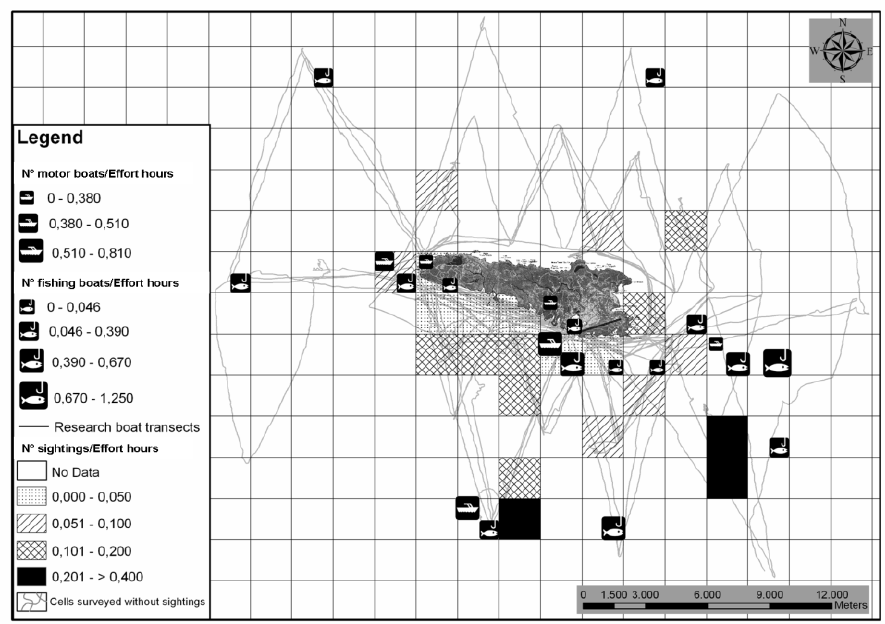
Figure 3. Sighting frequency, boat presence and research boat transects using vessel-based survey the spatial grid used in the figure is composed by cells of 1 nm 2